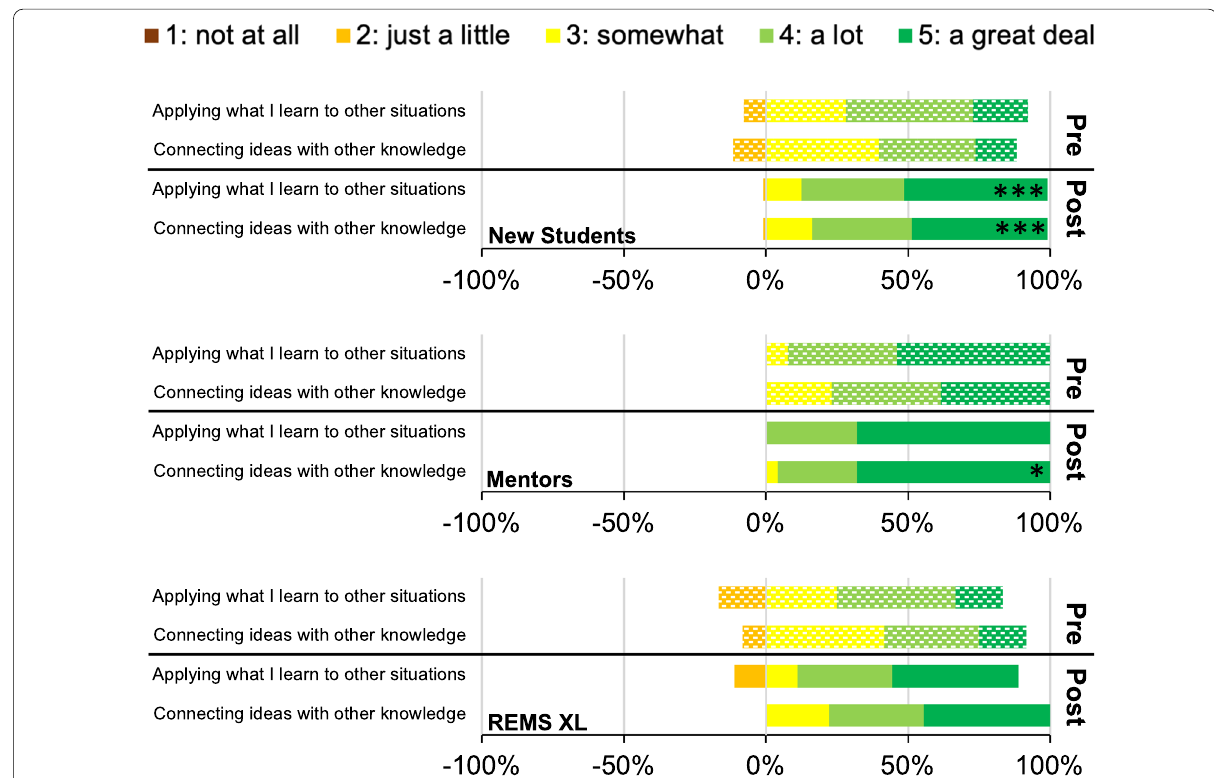
Fig. 20 Recognition: Pre- and post-program marine science use beyond the classroom. Student responses (New Students ( N ( N 26), REMS XL (12)) to REMS survey items (1 = beyond the classroom. Pre- and post-program differences were analyzed with a Mann–Whitney U -test. * p < 0.05. *** p <